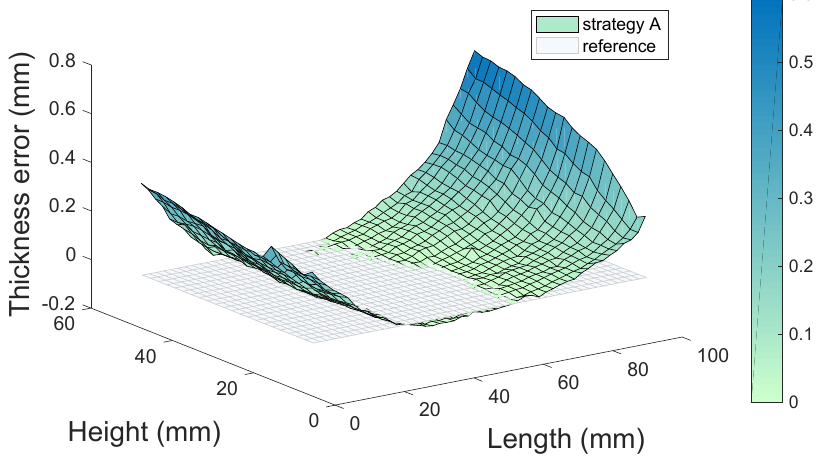
Figure 15. Airfoil thickness error for strategy A.